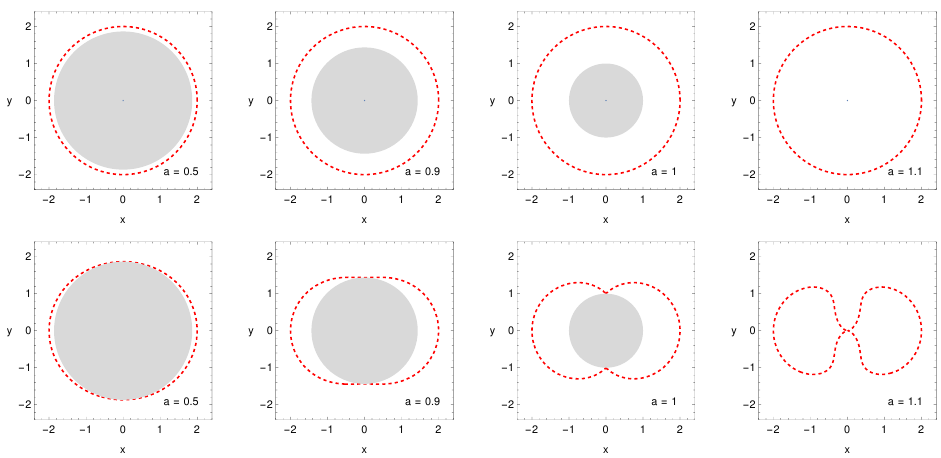
Figure 1. The ergosphere extension, represented by the equatorial and the meridional sections, is given for Kerr black holes and Kerr naked